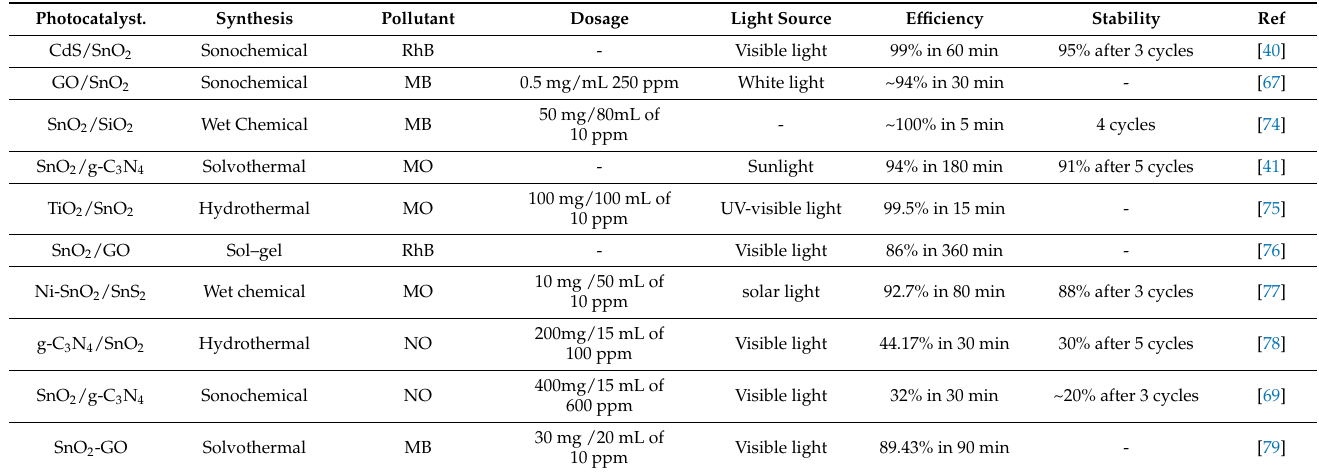
Table 3. Detailed description of recent research on the photocatalytic abilities of SnO 2 QD-based binary